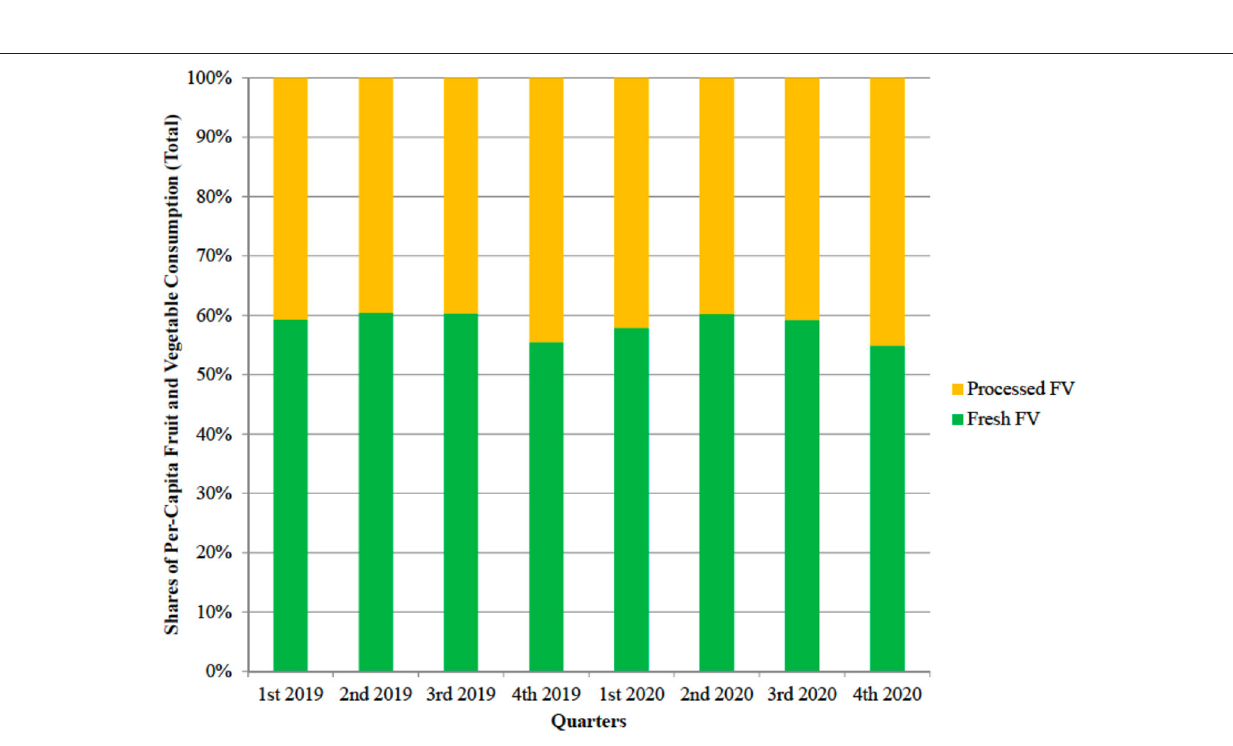
Frontiers in Nutrition |